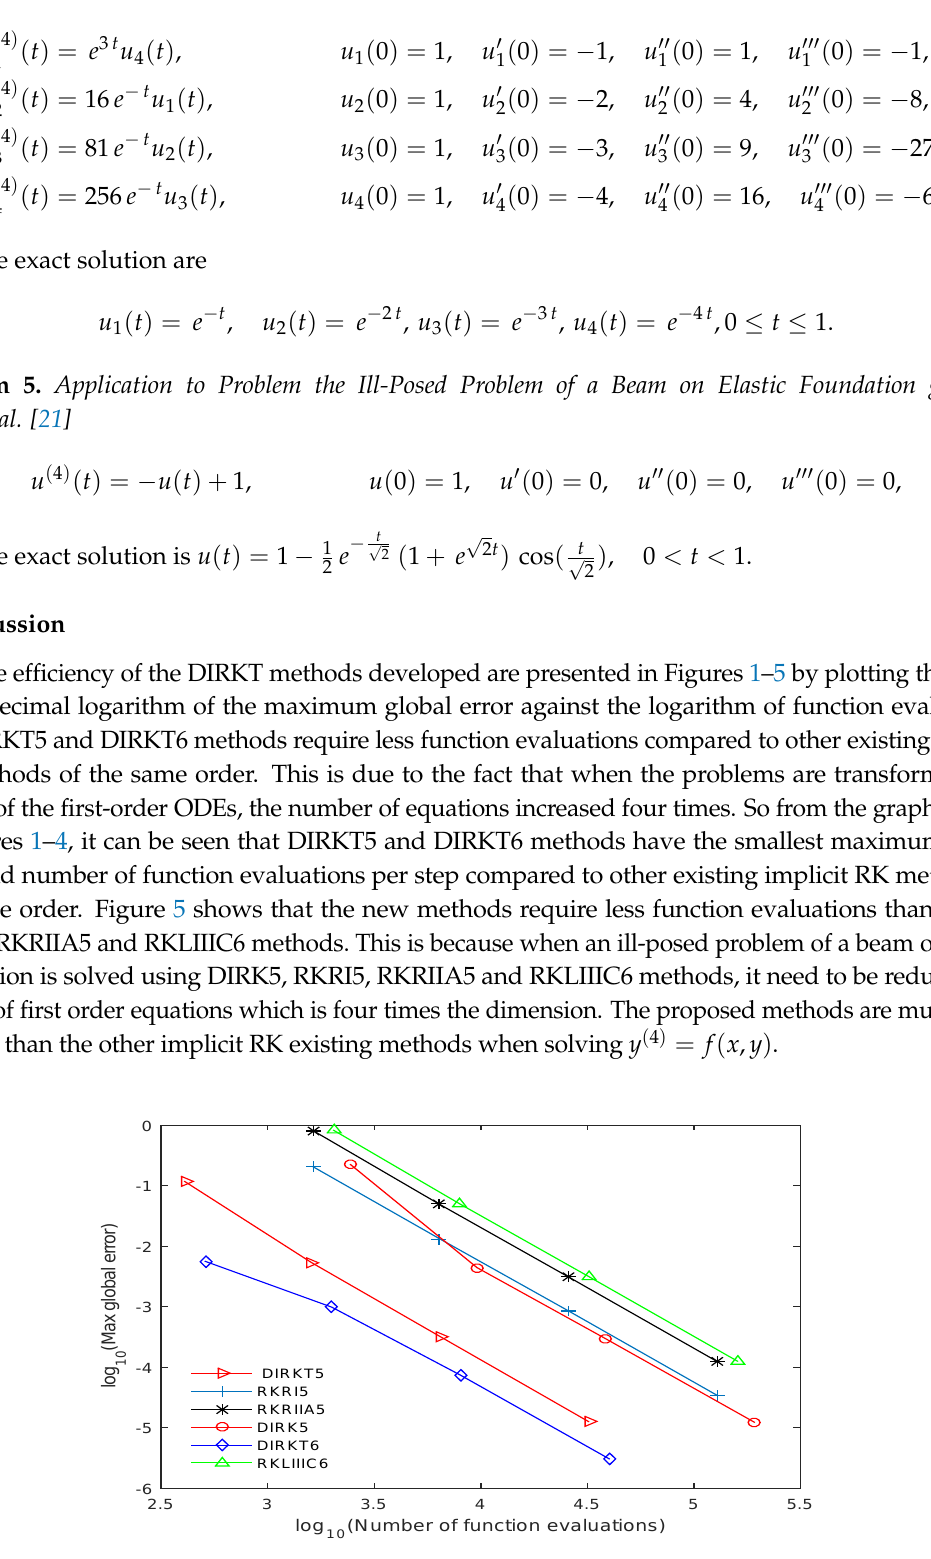
Figure 1. Accuracy curve for Problem 1 for DIRKT5, DIRKT6, DIRK5, RKRI5, RKRIIA5 and RKLIIIC6 methods with h =